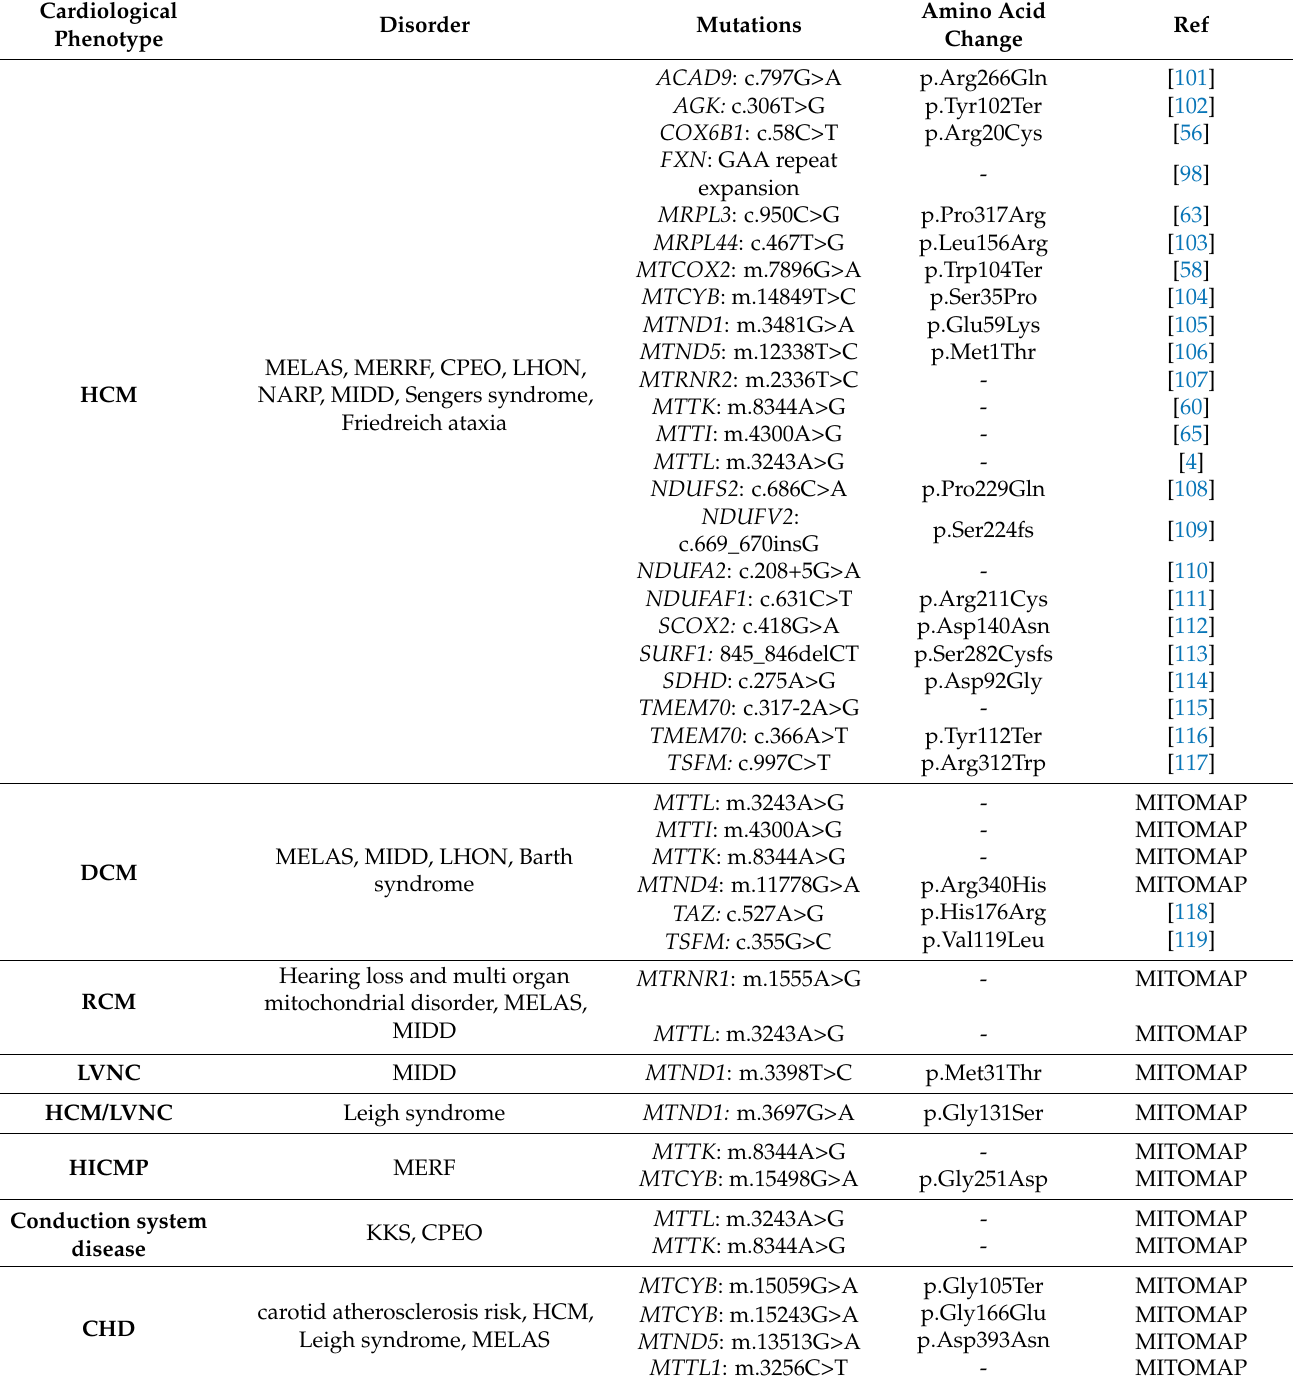
Table 1. List of known pathogenic mutations reported in association with cardiological phenotype, by MITOMAP database, literature data and using ACMG